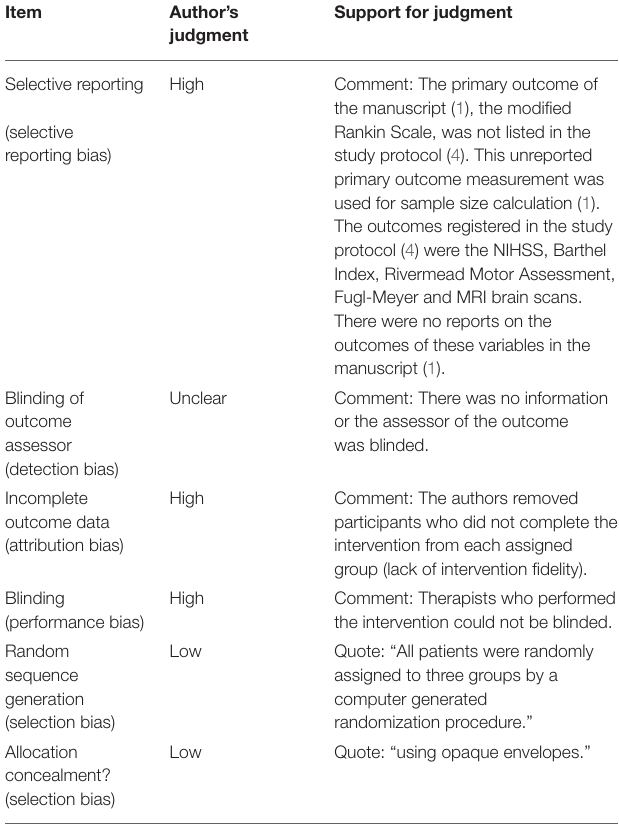
TABLE 1 | Risk of bias